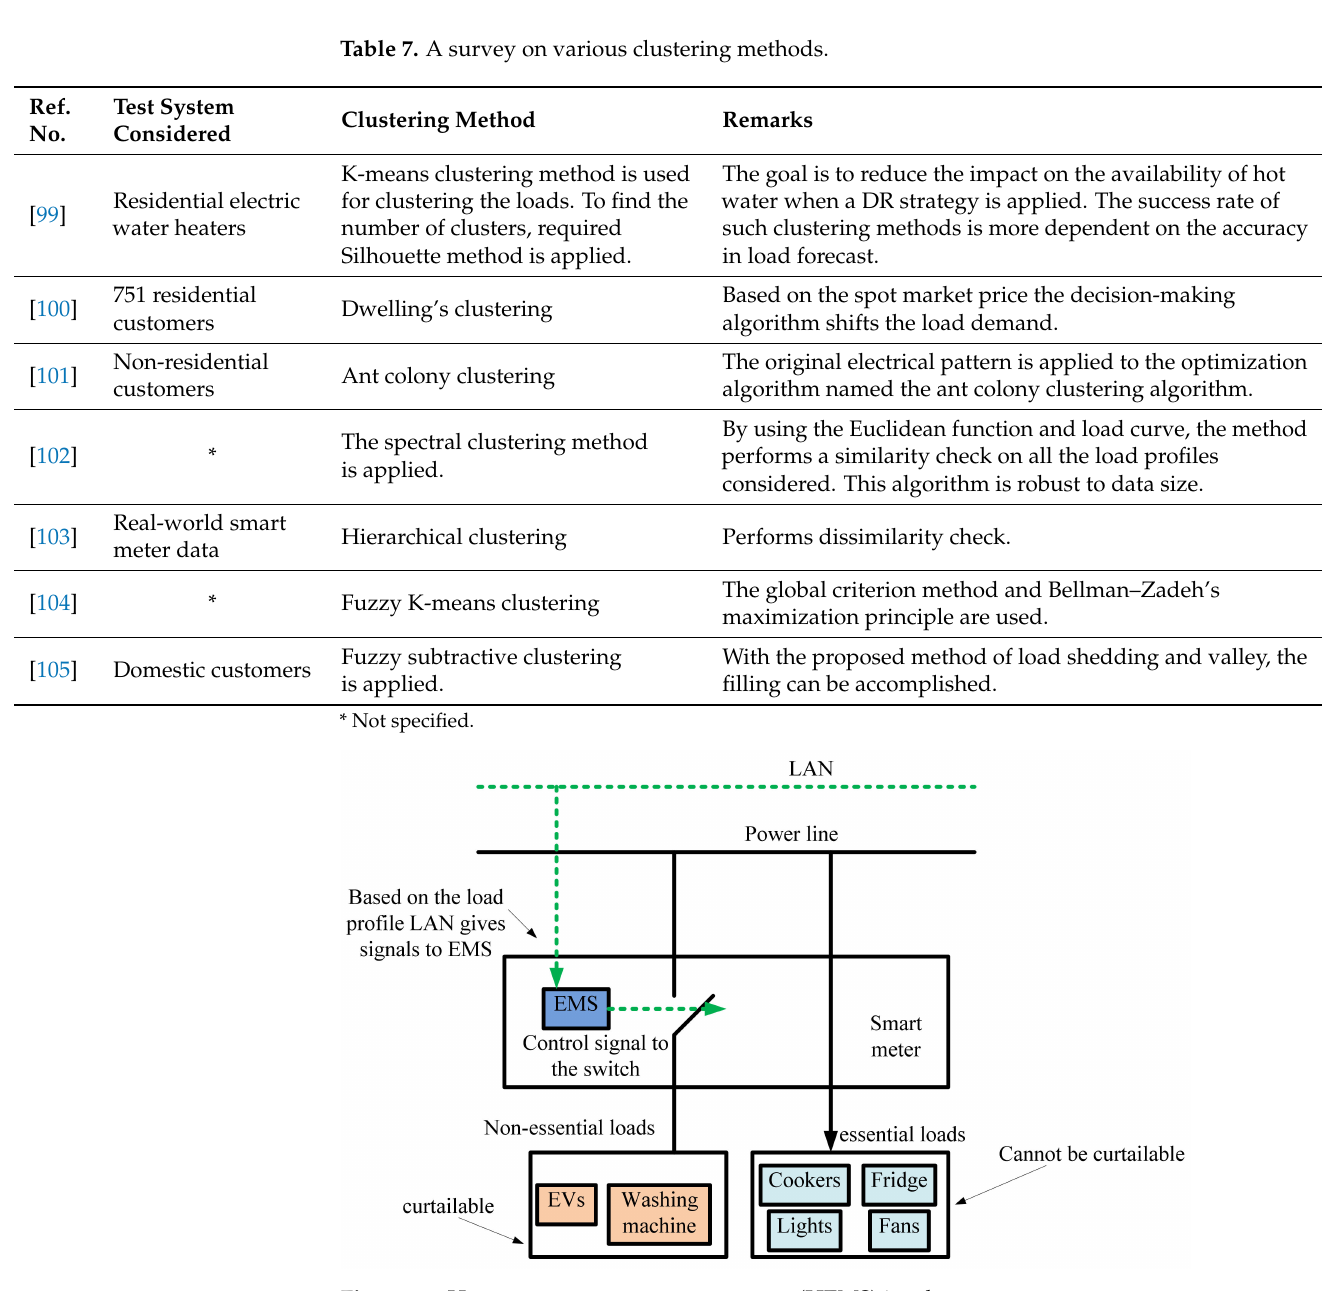
Figure 15. Home energy management system (HEMS) in a